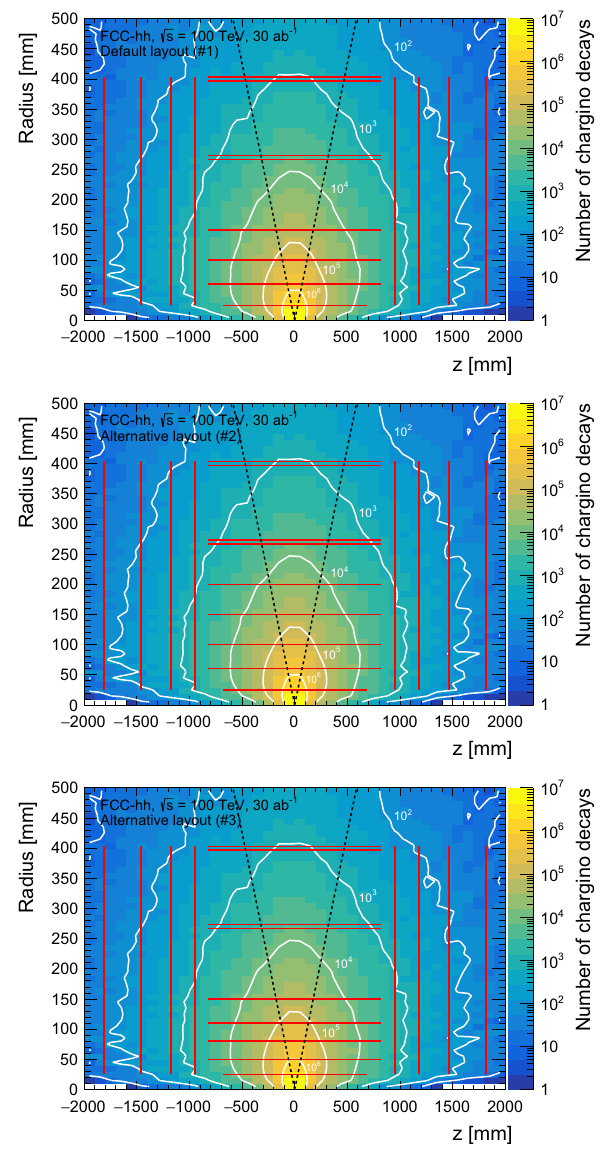
Fig. 1 Three barrel inner-tracker layouts considered in this study, the default layout #1 (top), the alternative layout #2 (middle) and the alter- native layout #3 (bottom). The difference between different layouts is restricted within R ≤ 200 mm and | z | ≤ 82 cm, and the detector con- figuration is identical outside the region. The contour drawn behind the layouts shows the number of chargino decays in 3 TeV wino sig- nal events with 30 ab − 1 at a given position. The analysis considers the region | η | < 1, denoted by the dotted lines